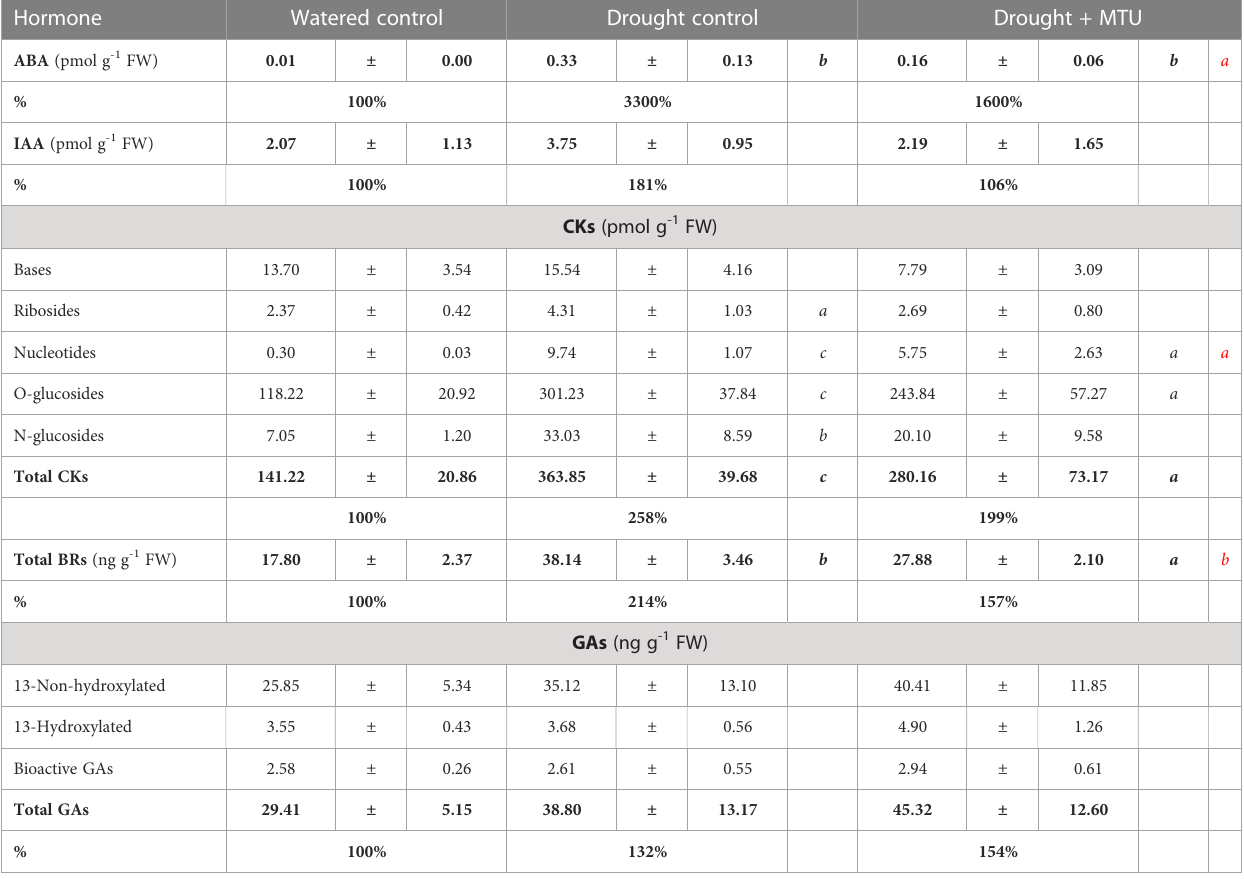
TABLE 2 Phytohormone levels in 25-day-old intact wheat shoots after 5 days of drought treatment (SRWC was 72%). Hormone Watered control Drought